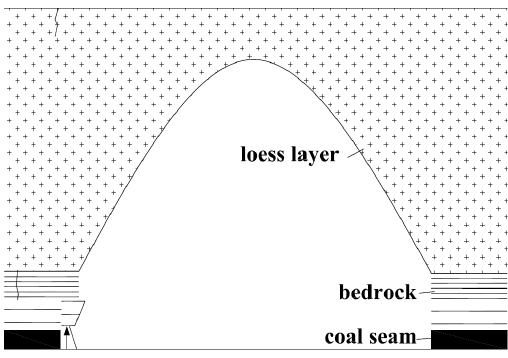
Figure 3. Surface damage caused by underground mining.